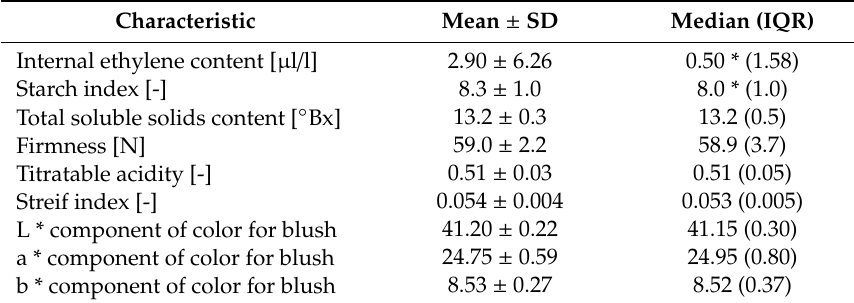
Table 1. Characteristics of ‘Idared’ apples assessed directly after